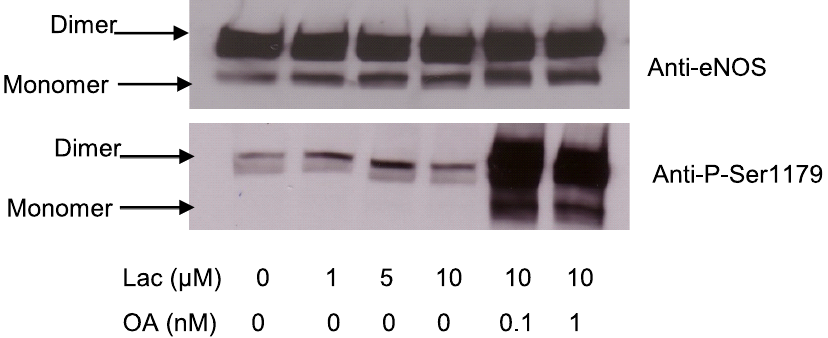
Figure 5. Inhibition of PP2A increased phosphorylation of Serine 1179 in eNOS dimer, but did not alter the eNOS dimer:monomer ratio in BAECs. BAECs were treated with lactacystin or okadaic acid overnight and the samples were run on SDS-PAGE gel at low temperature (4 u C) followed by western blot to determine eNOS phosphorylation and dimer:monomer ratio as described in the Materials and Methods.